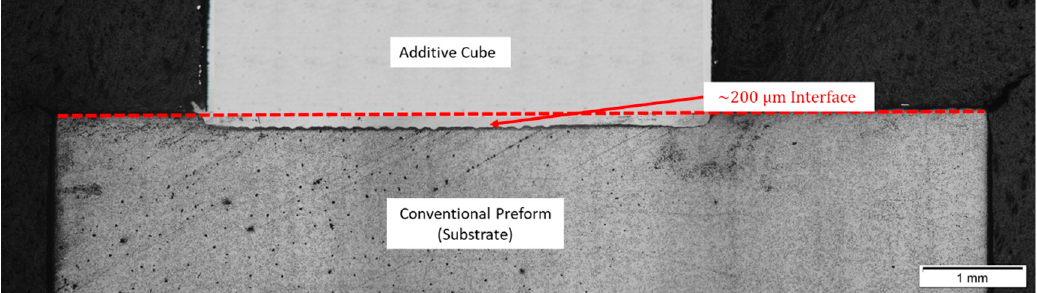
Figure 10. Cross-section of repaired sample. The interface was measured to be ~200 µm.